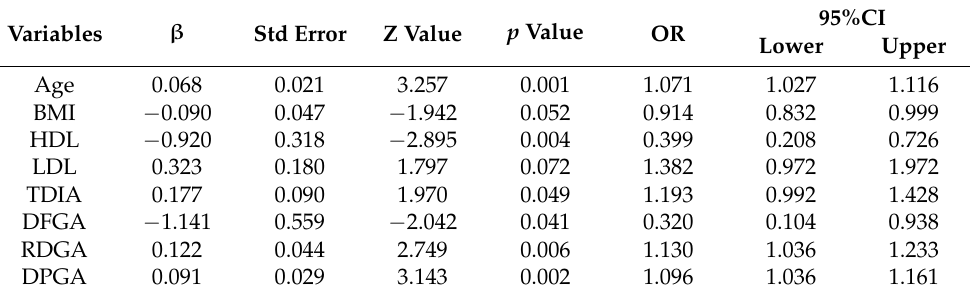
Table 2. MCI risk prediction model for the middle ‐ aged and elderly.